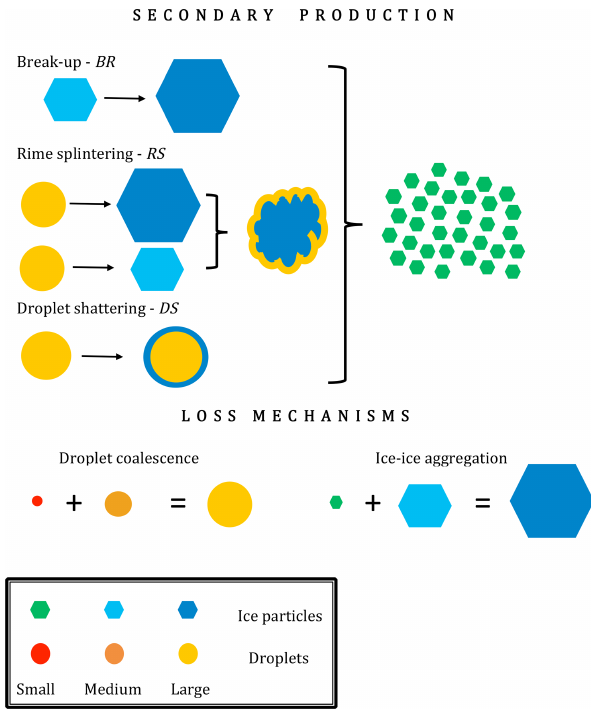
Figure 3. Schematic representation of the simplified six-bin micro- physics (adapted from Sullivan et al.,